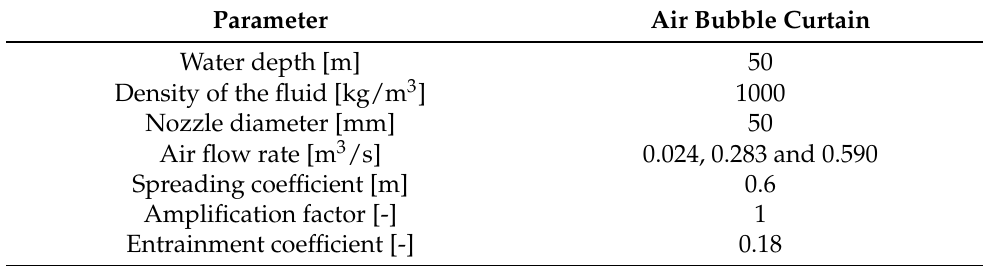
Table 1. Basic input parameters of the air bubble curtain